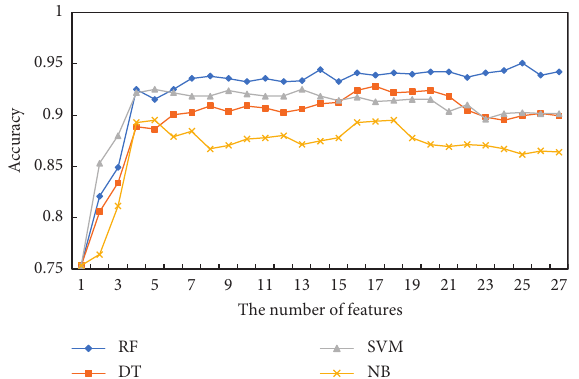
Figure 4: According to the features ranking.